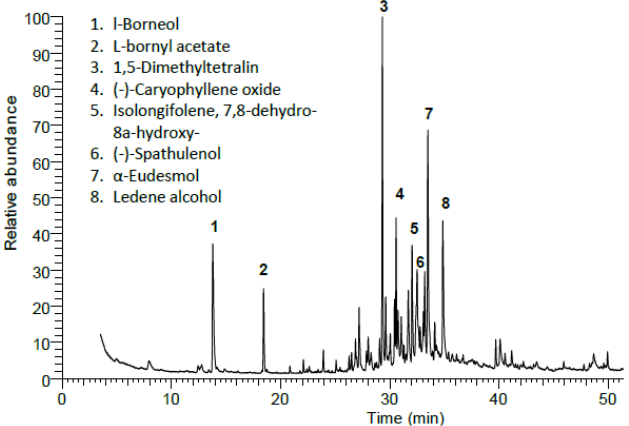
Figure 1. Gas chromatography-mass spectrometry (GC-MS) chromatogram of essential oil (EO) from the leaves of Egyptian X. strumarium . The peaks with numbers represent the major compounds.